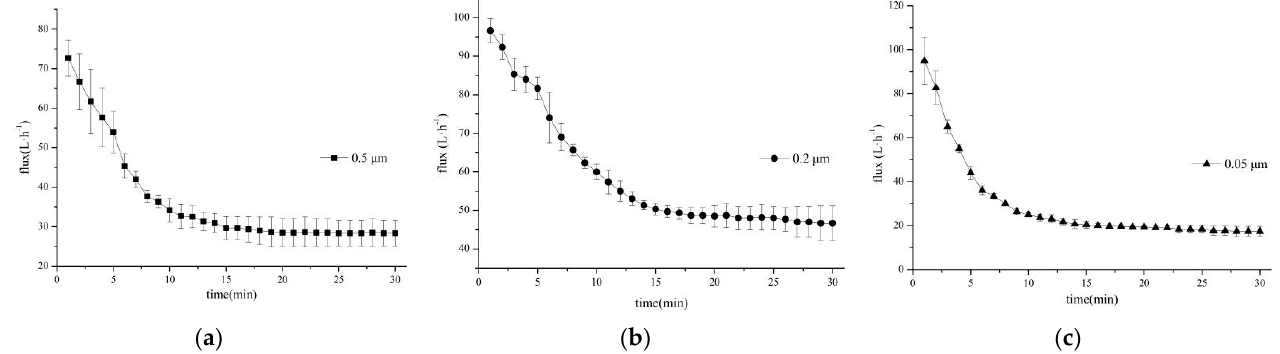
Figure A1. ( a ) 0.5 μ m flux decay curve; ( b ) 0.2 μ m flux decay curve and ( c ) 0.05 μ m flux decay curve.